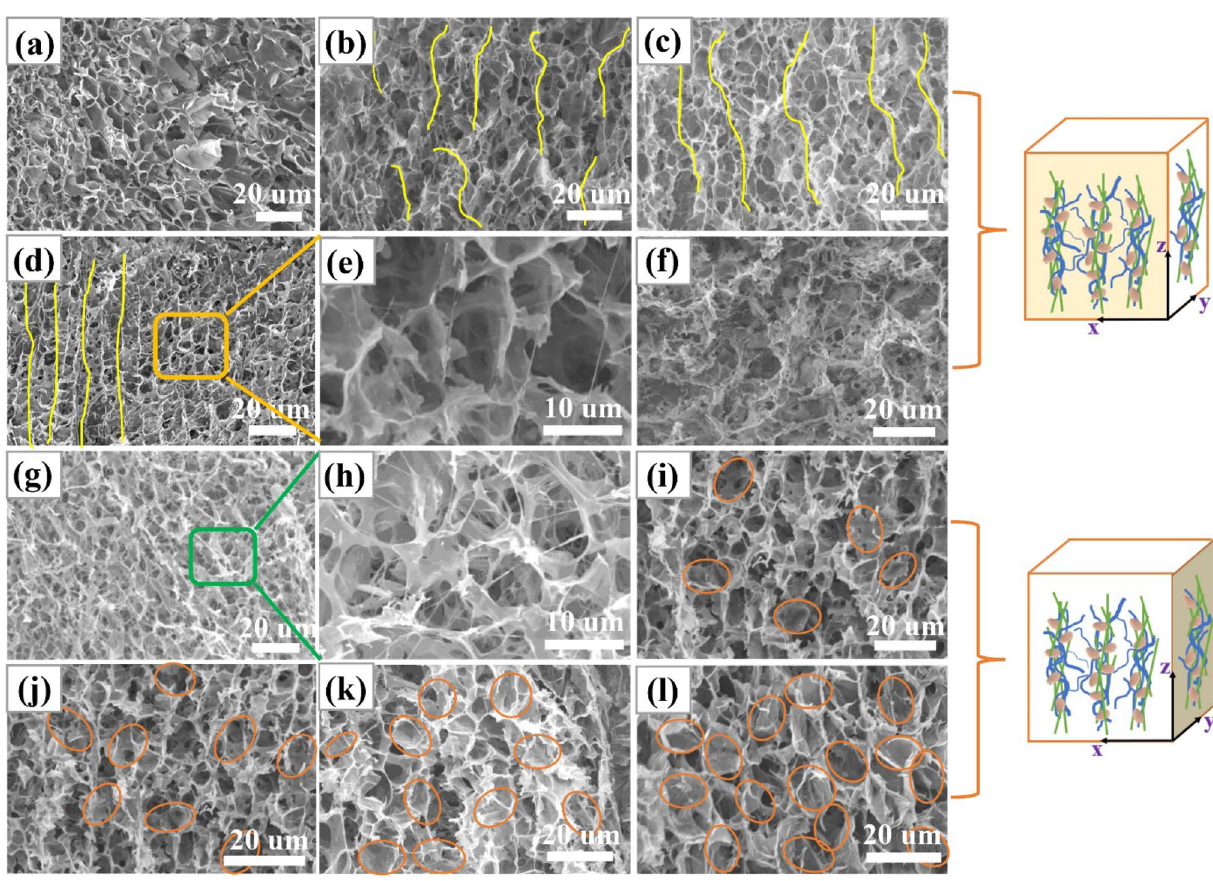
Fig. 5 SEM images of CA/m‑SiC NW S /m‑BN with different contents of m‑SiC NW S and GO and m‑BN. a–d and f are the section mor‑ phologies of CA/1.8 m‑BN, CA/0.03 m‑SiC/1.8 m‑BN, CA/0.06 m‑SiC/1.8 m‑BN, CA/0.10 m‑SiC/1.8 m‑BN and CA/0.13 m‑SiC/1.8 m‑BN skeleton in x – z plane. e is local enlarged drawing of d. g , i–l are the section morphologies of CA/0.10 m‑SiC, CA/0.10 m‑SiC/0.5 m‑BN, CA/0.10 m‑SiC/1.0 m‑BN, CA/0.10 m‑SiC/1.5 m‑BN and CA/0.10 m‑SiC/1.8 m‑BN skeleton in x – y plane. h is local enlarged drawing of